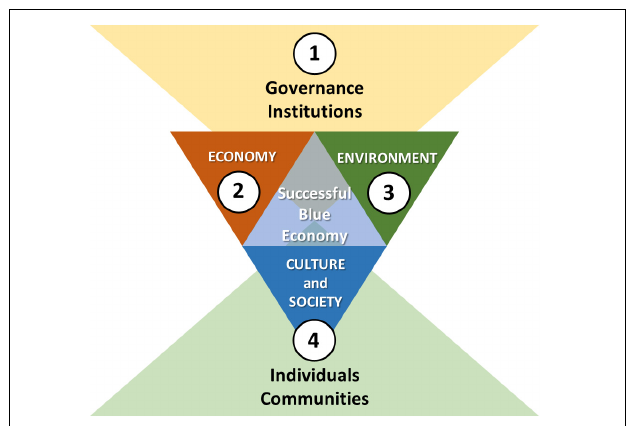
FIGURE 2 | Representation of the blue economy triangle (comprising culture and society, economy and environment); the top-down policy-driven and bottom-up community-led approaches needed for a successful blue economy; and the four key components of sustainability: (1) governance and institutions, (2) economy, (3) environment, and (4) culture and